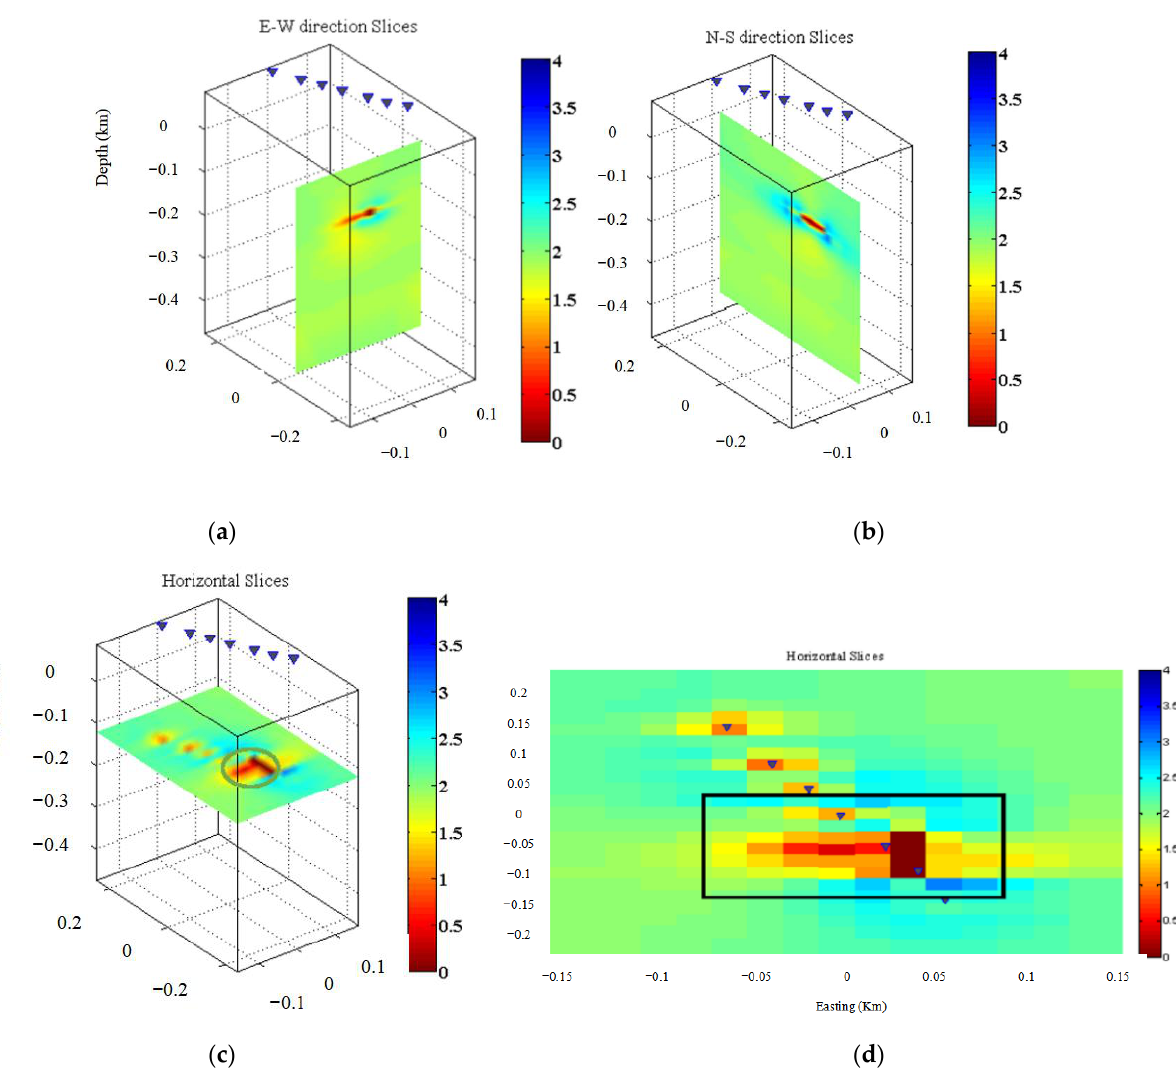
Figure 11. 3D AMT inversion results of the No. 02 coal mining area. ( a ) Slices in the EW direction; ( b ) slices in the NS direction; ( c ) horizontal direction slice at the depths from 120 m to 125 m; ( d ) the horizontal view of the slice in ( c ). The resistivity data is lg( Ω·m ). AMT sites are shown by blue triangles in each figure.